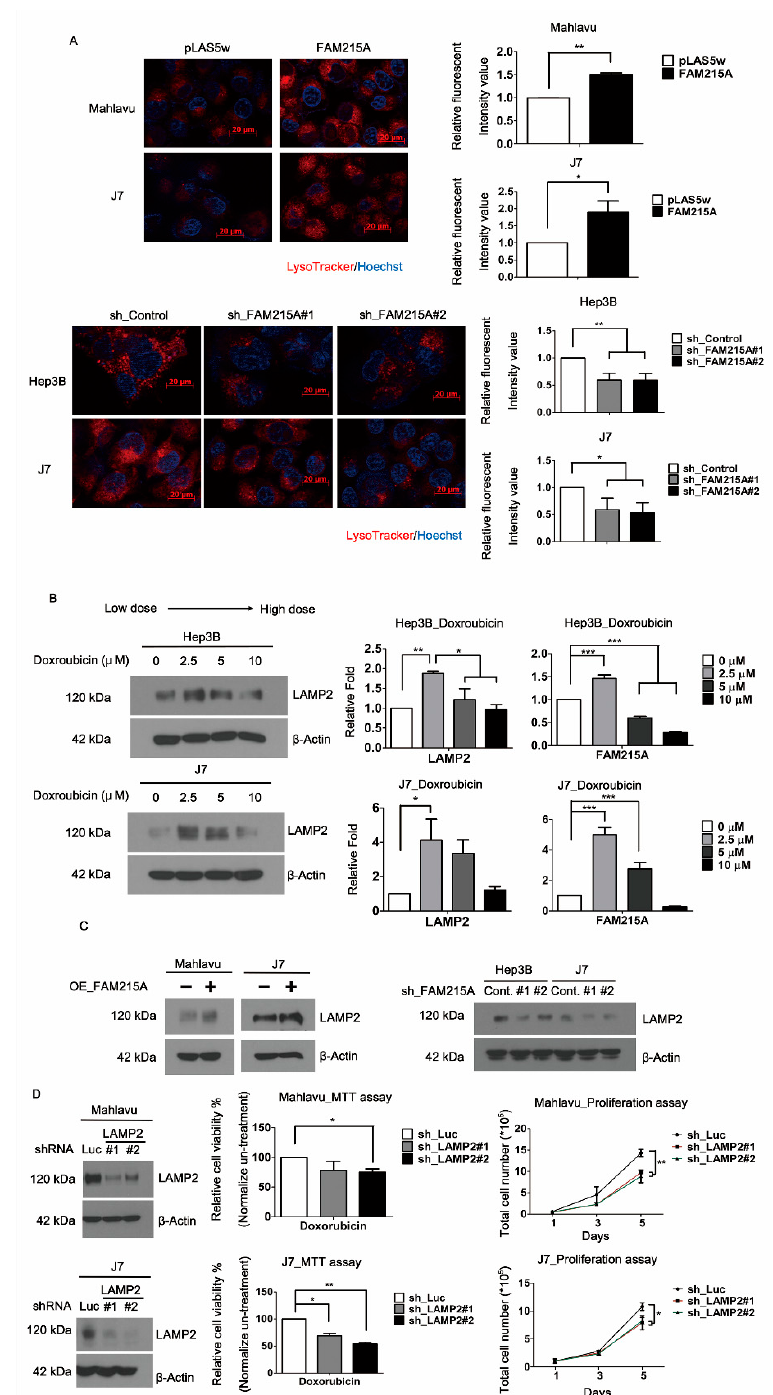
Figure 4. FAM215A a ff ects lysosomes and the oncogene LAMP2 expression in HCC. ( A ) Lysosome expression (red fluorescent) in FAM215A-expressing or knockdown J7 cells determined by LysoTracker. Blue fluorescent is Hoechst that indicates nucleus. The signal was detected by fluorescence microscopy images and analysis with ImageJ. ( B ) The e ff ects of Doxroubicin (0–10 µ M, 24hours) on the expression of FAM215A and LAMP2 detected by Western blot and qRT-PCR. ( C ) Expression of LAMP2 in FAM215A-expressing or knockdown cells assayed by Western blot. ( D ) Proliferation rate measured by MTT in LAMP2-depleted Mahlavu and J7 cells with / without 5 µ M Doxroubicin for 24 h. All the data are normalized with un-treatment groups. Data are presented as means ± SD of three independent experiments (*, p < 0.05; **, p < 0.01; ***, p < 0.001).